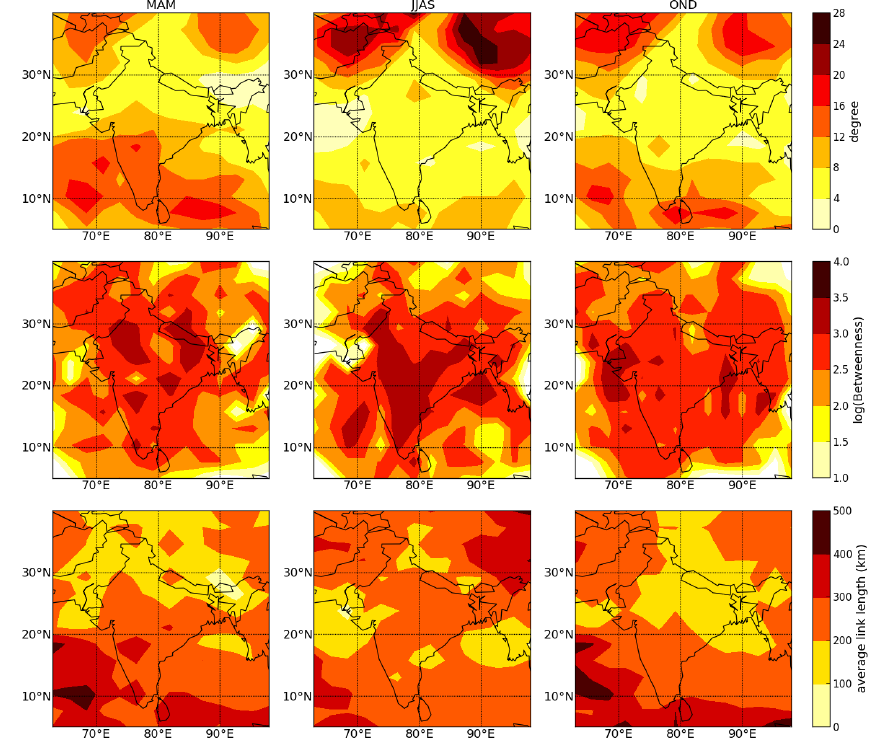
Figure 8. Common network measurements for the three time periods based on the NCEP/NCAR data for the pre-monsoon (MAM), monsoon (JJAS), and post-monsoon (OND) temperature networks. From top to bottom: degree, betweenness, average geographical link